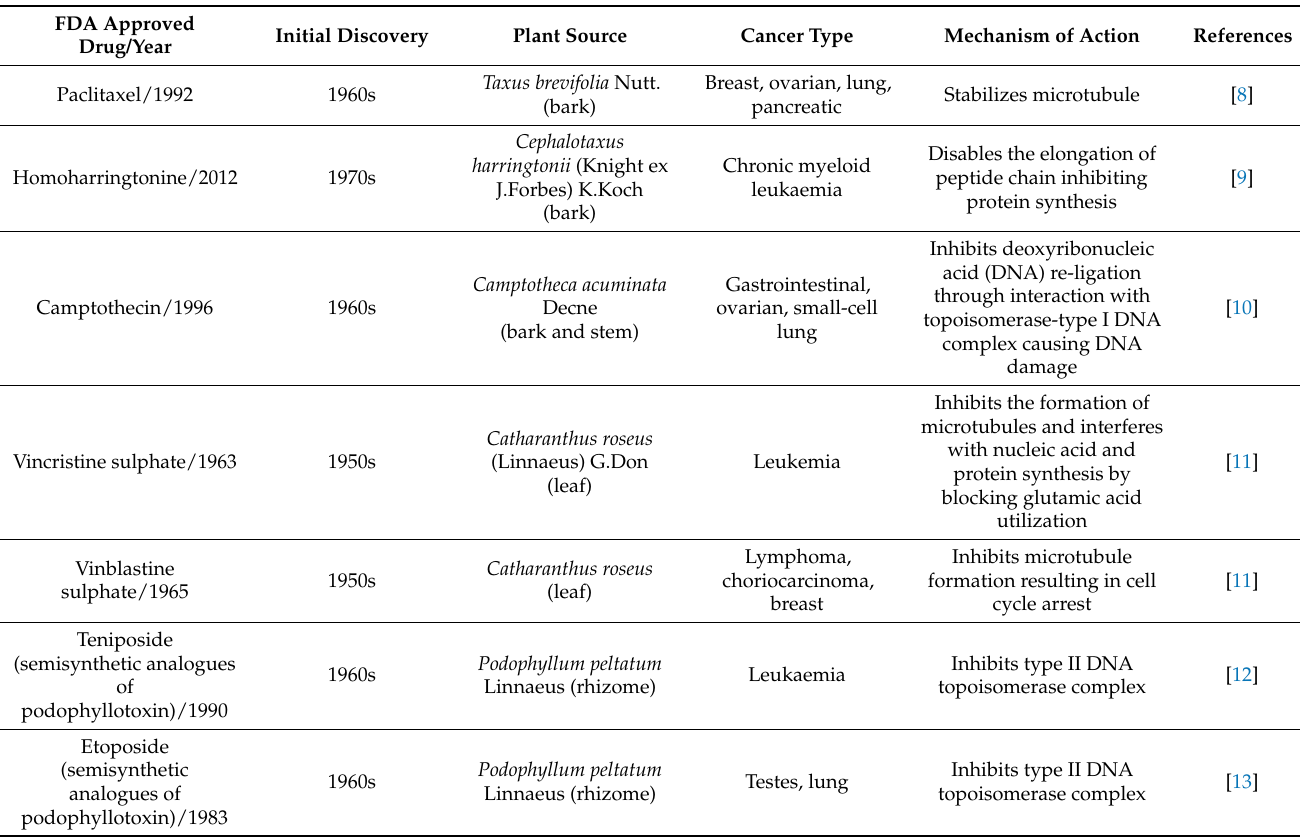
Table 1. FDA-approved plant-derived anticancer drugs; time frame of approval and mechanisms of